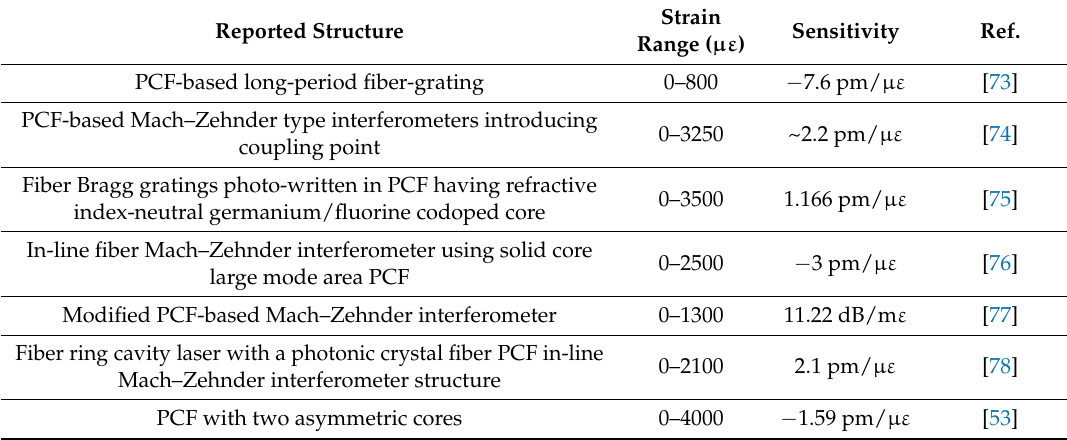
Figure 18. SEM image of twine core PCF. Ten centimeters of this fiber were used to form an in-fiber Mach – Zehnder interferometer for strain measurement (Reproduced from [71], with the permission of Elsevier publishing). Table 3. Comparative representation of different PCF-based strain sensors.